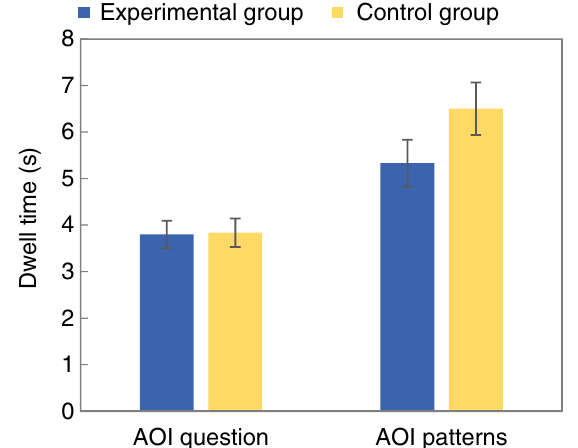
FIG. 6. Mean dwell times of students in the experimental and control group for AOI question and AOI patterns. The error bars represent 1